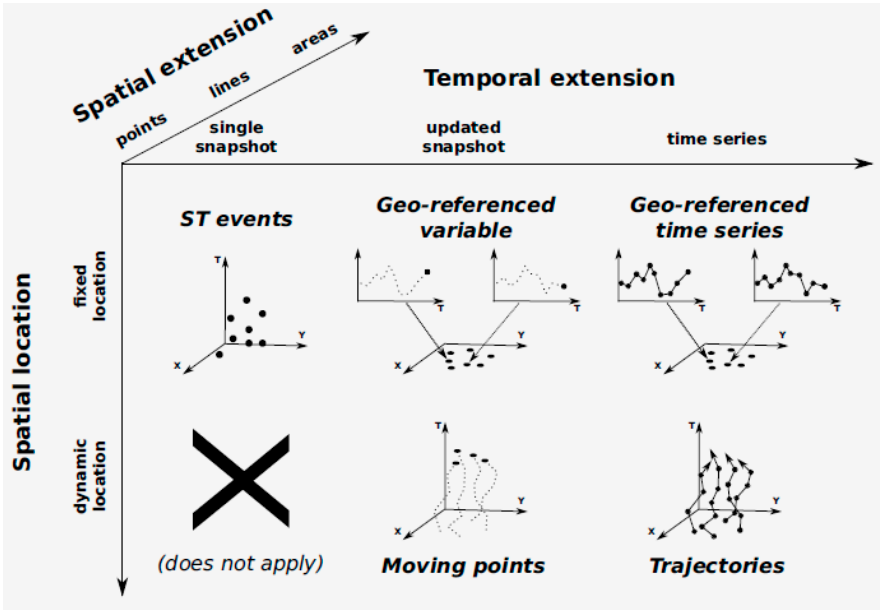
Figure 1. Context for spatiotemporal (ST) clustering (source: Kisilevich, et al. [3]).